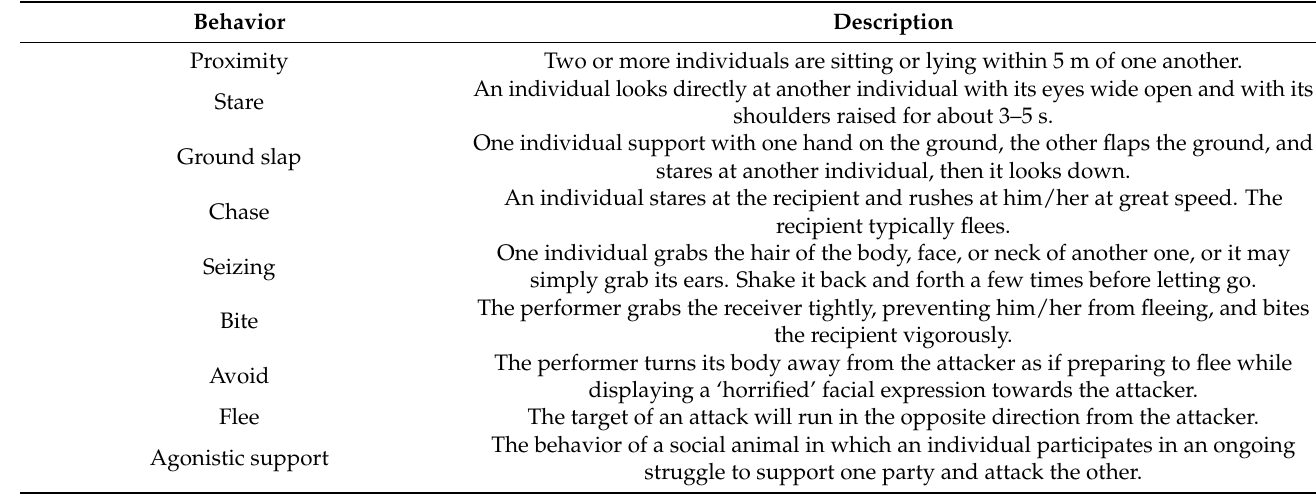
Table 1. Definitions of behaviors in Tibetan